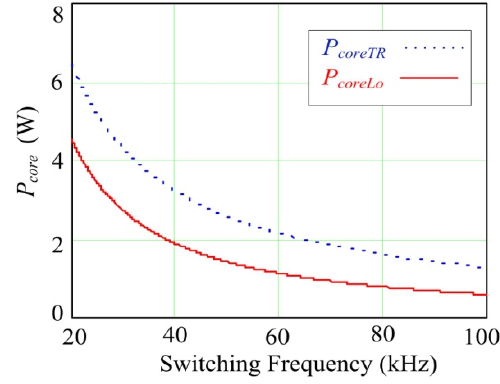
Figure 5. Core losses versus switching